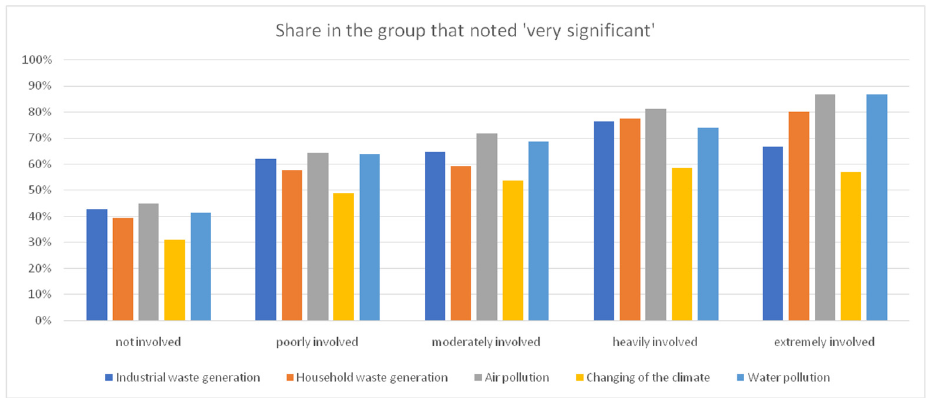
Figure 3. Attitude of respondents to environmental issues.